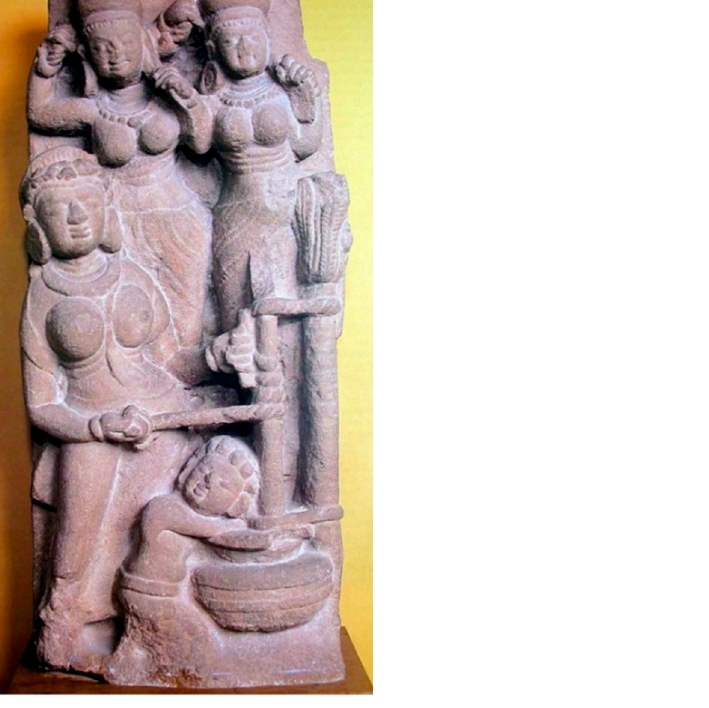
Figure 1. Churning of Butter, fourth–sixth century. V ā r ā nas ī , Uttar Pradesh. Sandstone. Bharat Kala Bhavan (BKB 180).